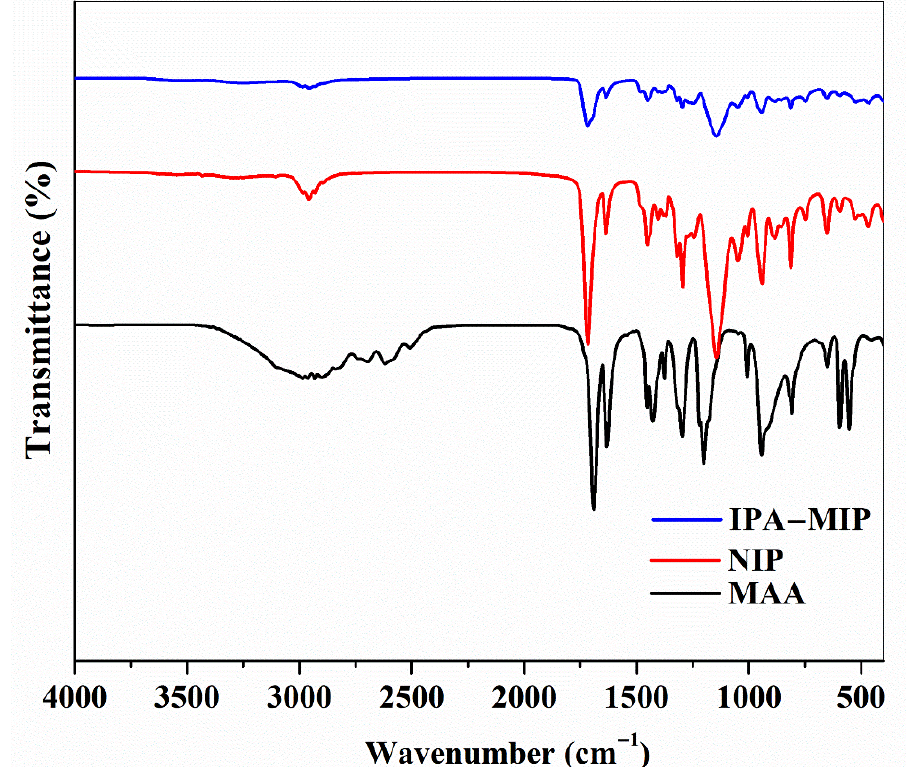
Figure 4. FTIR analysis for the IPA–MIP, NIP, and MAA.